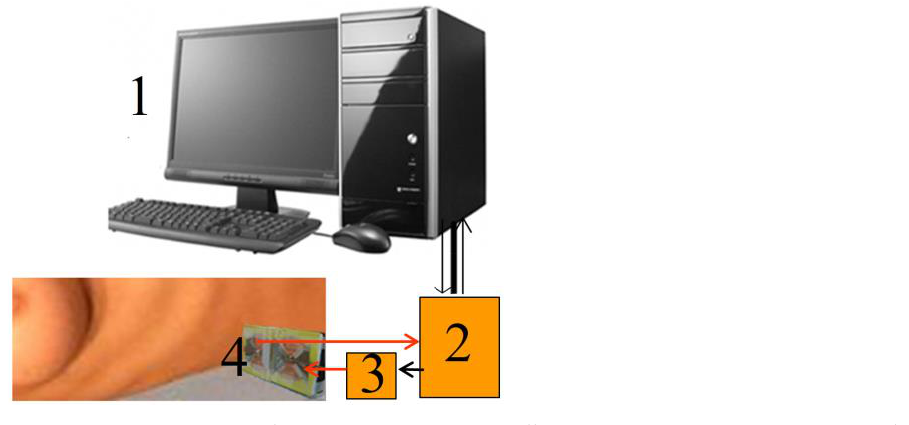
Figure 5. Measurements scheme: 1, computer; 2, oscilloscope; 3, generator; 4, receiving and transmitting antennas.